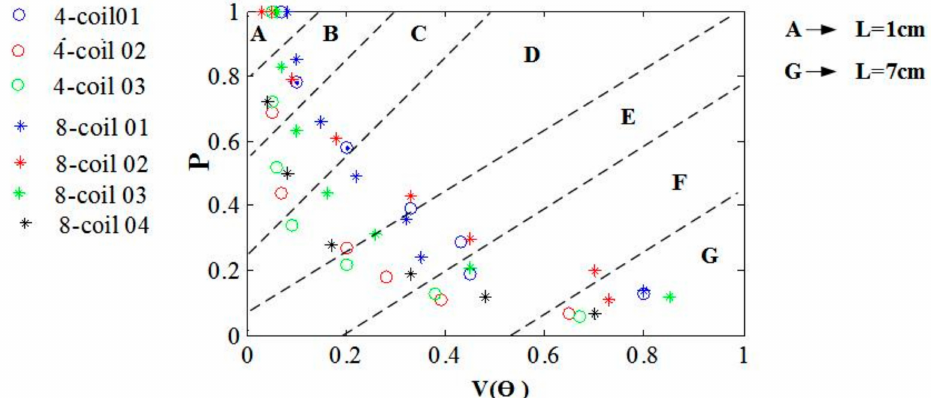
Figure 9. Strengths of the induced EFs at different depth are normalized with respect to the maximum EF amplitude estimated on the cortex. The values of proportion are represented with P. V ( θ ) shows the activated volume of the head model. The depths of brain tissue are marked A–G, which correspond to L from 1 to 7